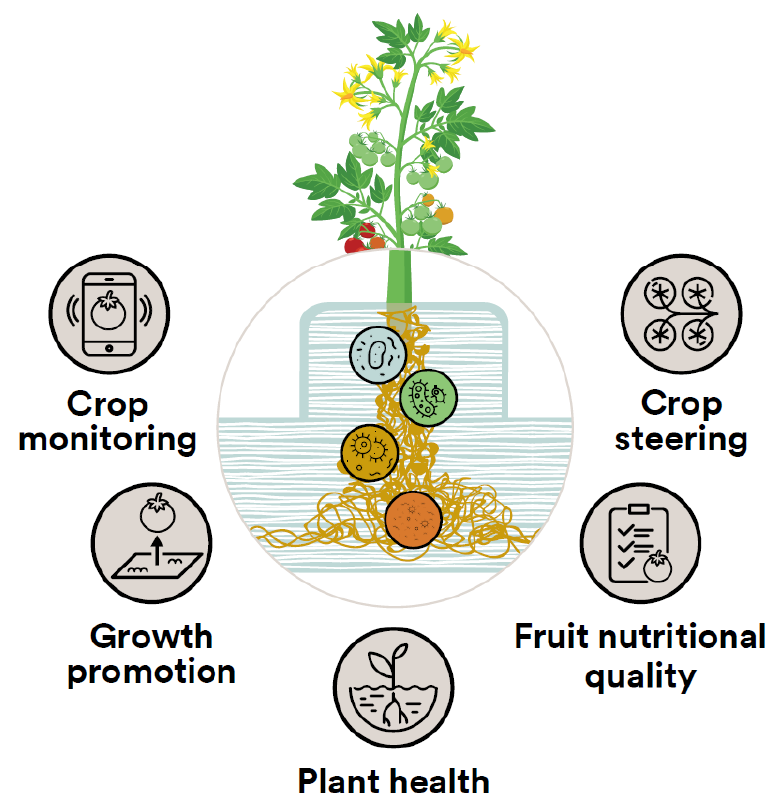
Figure 5. Potential applications of emerging host–microbiome research in hydroponic horticulture: crop monitoring and steering; plant growth promotion; and enhancement of plant health and fruit quality.